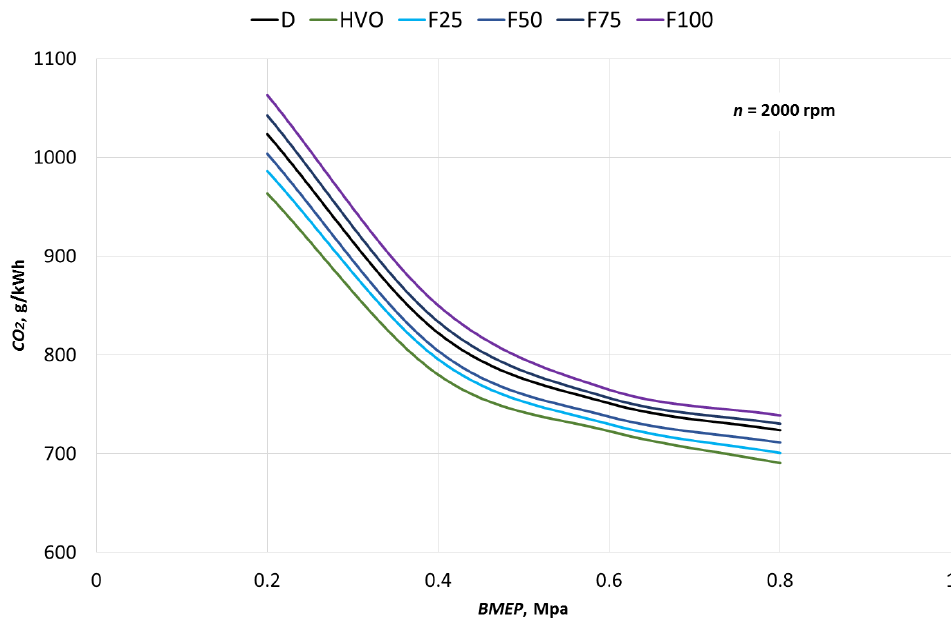
Figure 7. Dependence of carbon dioxide emissions on the load using different fuels.